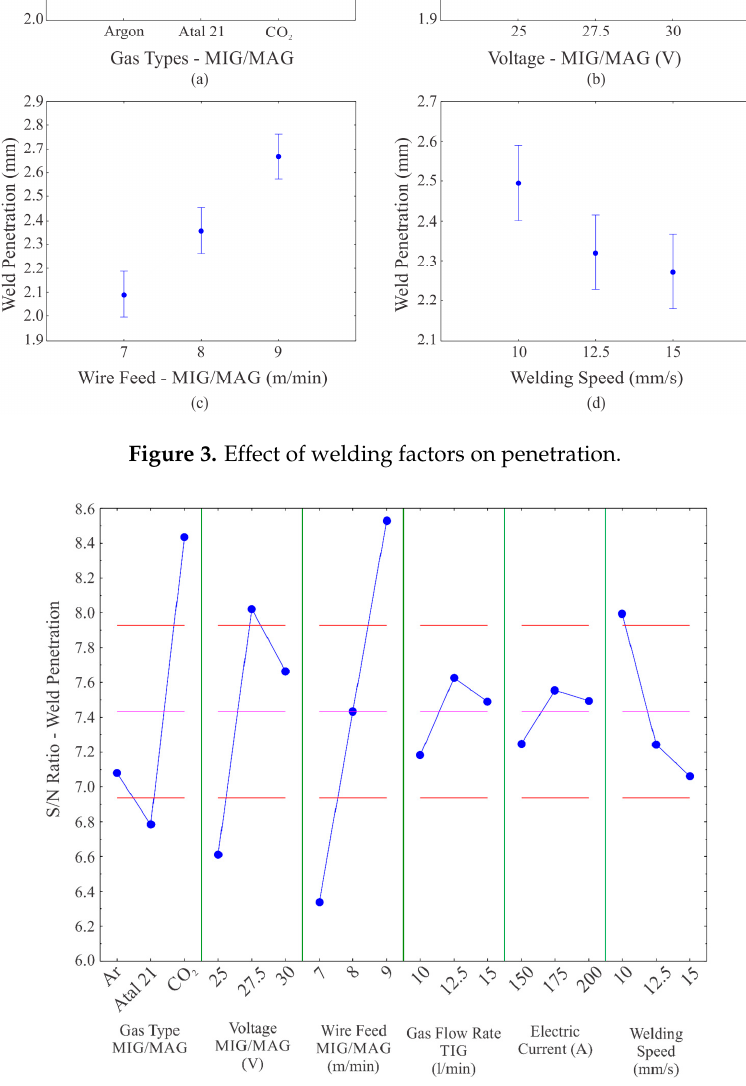
Figure 4. S/N ratio of the penetration of the solder.